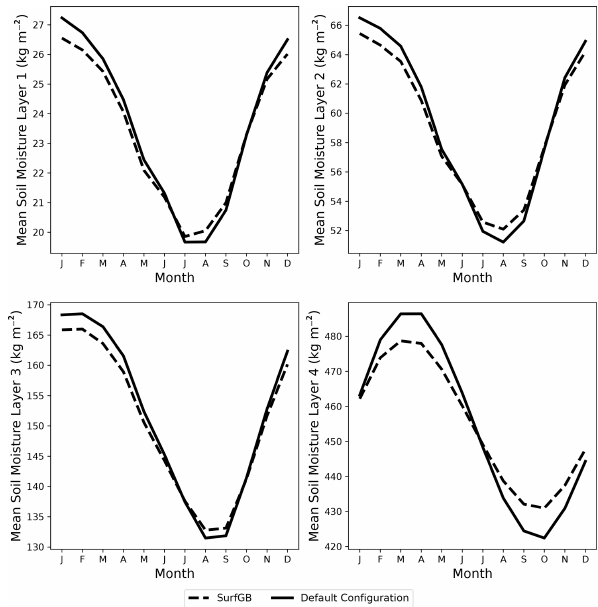
Figure 5. Grid box mean annual cycles of soil moisture in model layers for SurfGB (dashed line) and DC (Default Configuration) (solid